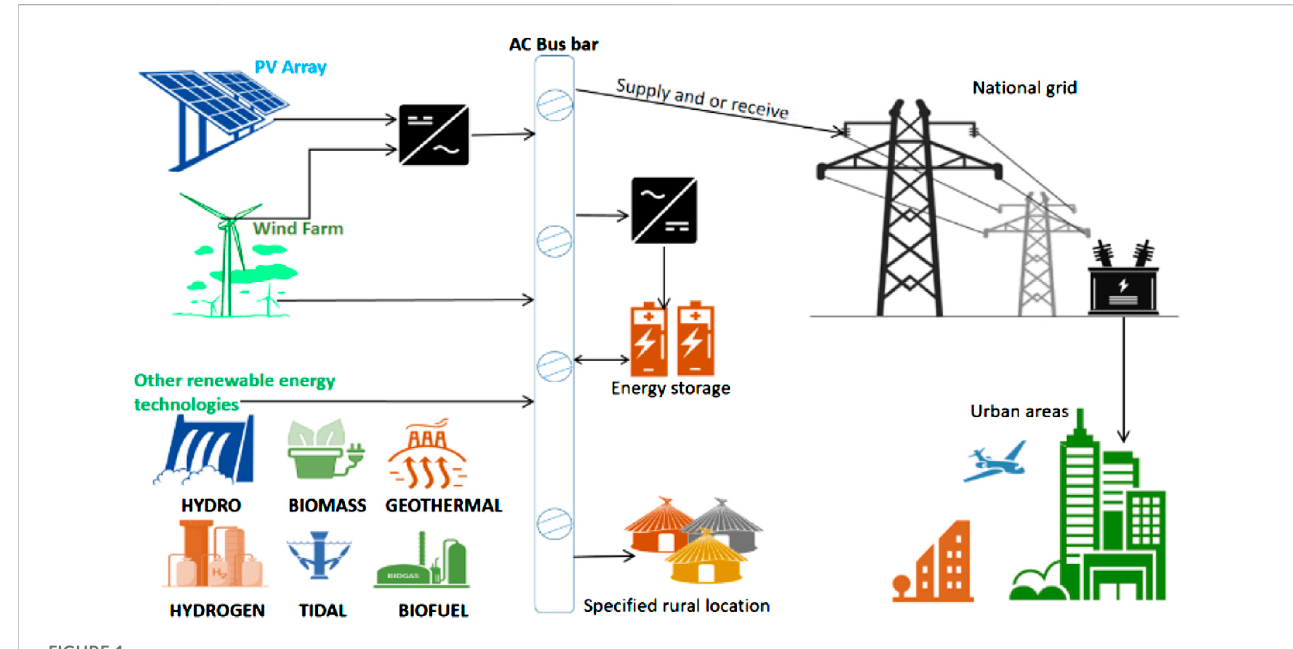
FIGURE 1 Renewable energy technologies of mini-grid